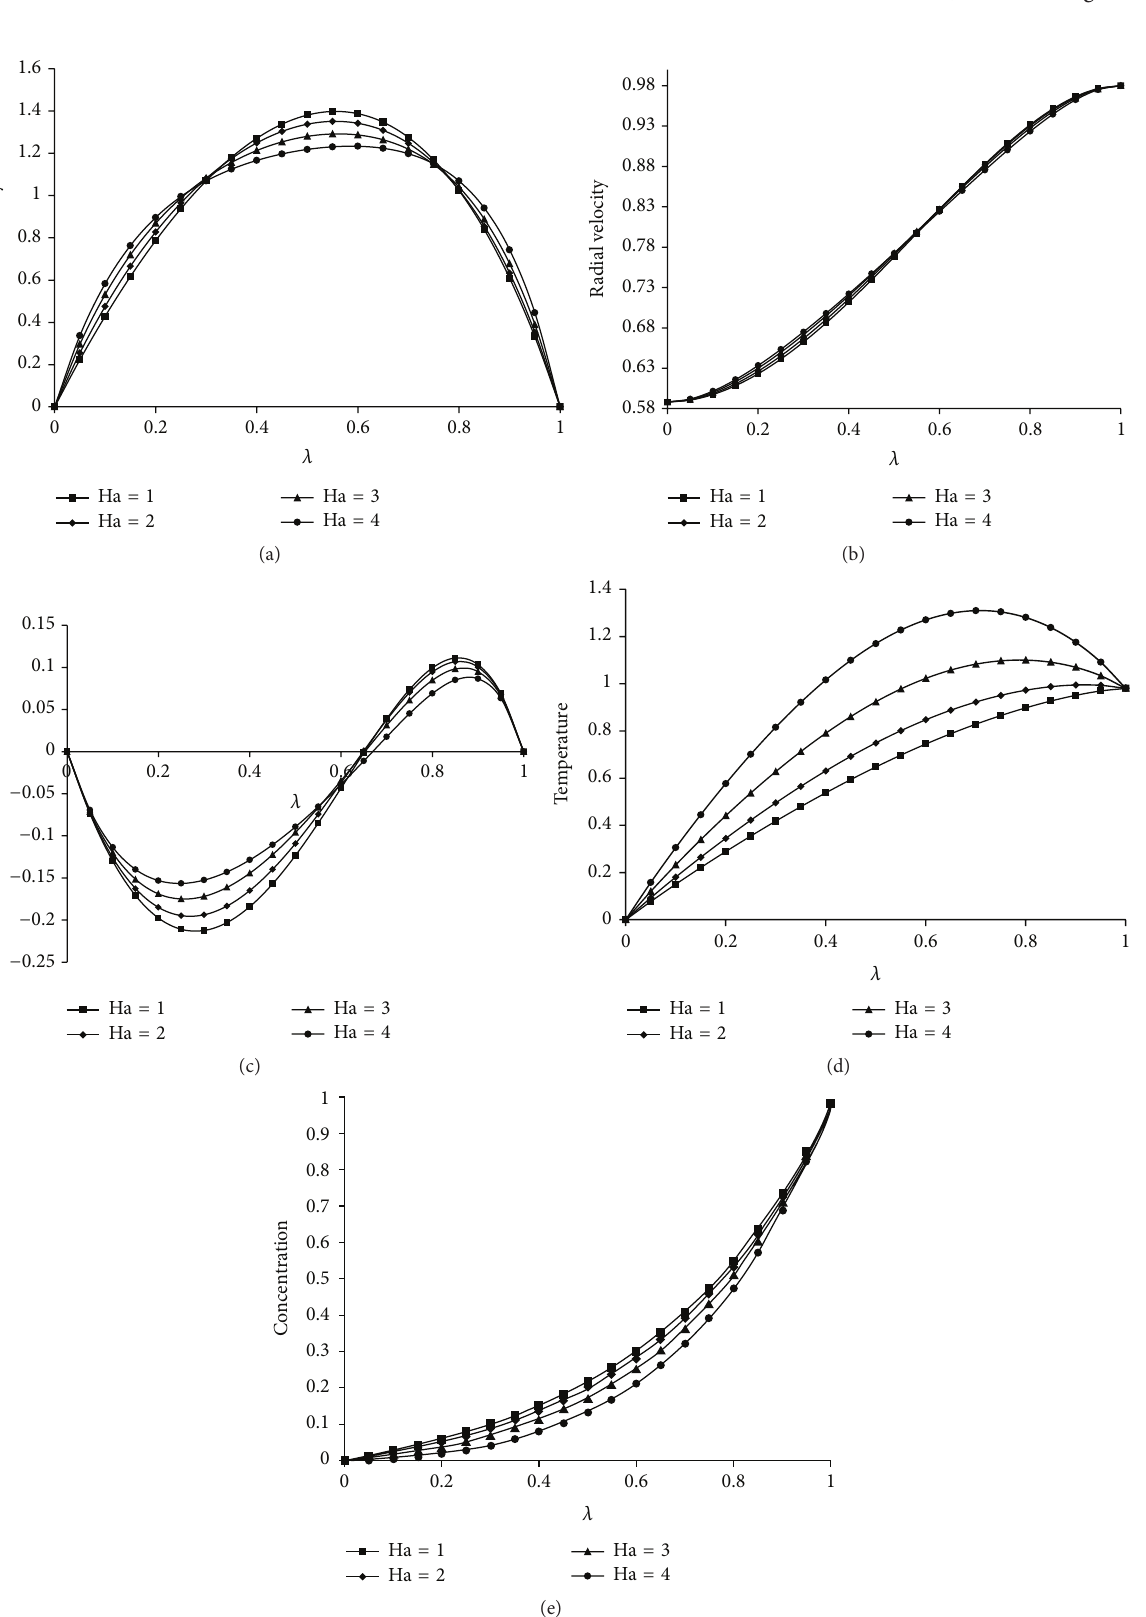
Figure 7: Effect of Ha on (a) axial velocity, (b) radial velocity, (c) microrotation, (d) temperature, and (e) concentration for Kr = 2, Du = 0.02, Gr = 4, Re = 2, Sr = 0.2, Sc = 1, Pr = 0.2, 𝑎 = 0.4 , 𝜓 = 0.2 , 𝑅 = 2 , 𝐽 1 = 2 , 𝑠 1 = 2 , 𝑠 2 = 2 , Gm = 4, 𝐷 −1 = 0.2 , and Ec =